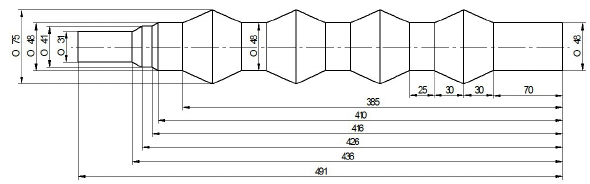
Figure 2: Analyzed crankshaft preform.